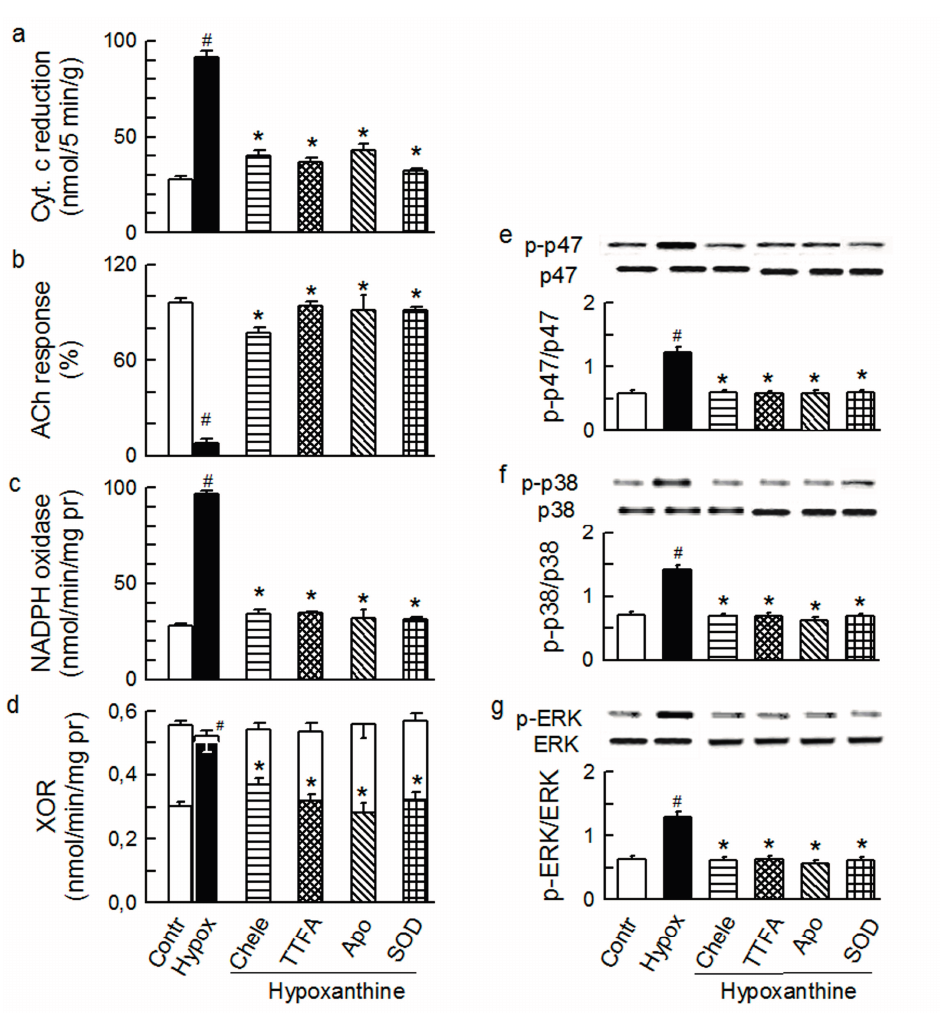
Figure 10. Effect of hypoxanthine (20 μ M) on the total outflow of reduced cytochrome c ( a ); normalised acetylcholine (ACh) response ( b ); NADPH oxidase activity ( c ); xanthine oxidoreductase activity (XOR) ( d ); phosphorylation of Ser345-p47phox ( e ), p38 ( f ) and ERK1/2 ( g ) in guinea-pig hearts. Hypoxanthine was administered either alone or in combination with (from left to right): 4 μ M chelerythrine (Chele), 5 μ M TTFA, 1